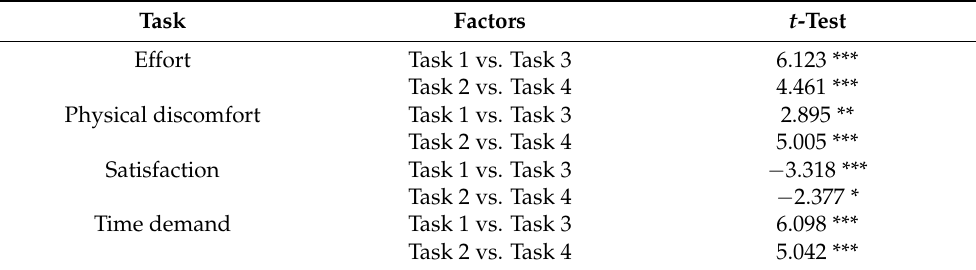
Table 4. Results for paired sample t -test for the three factors detected and the time demand item.